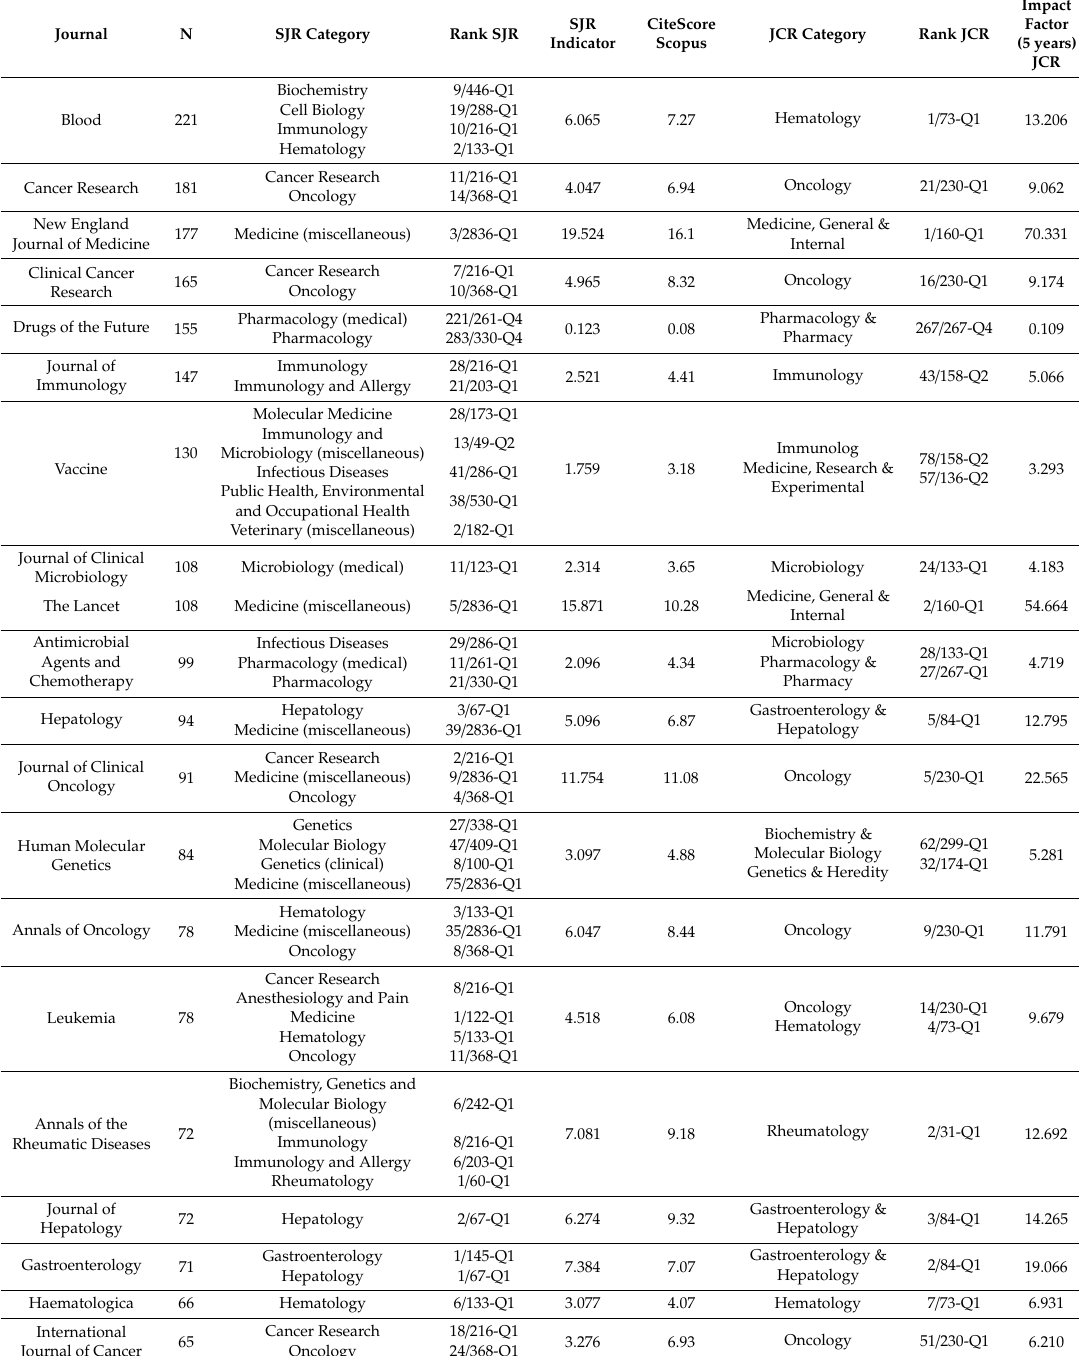
Table 12. Top 20 journal in medicine category. Data